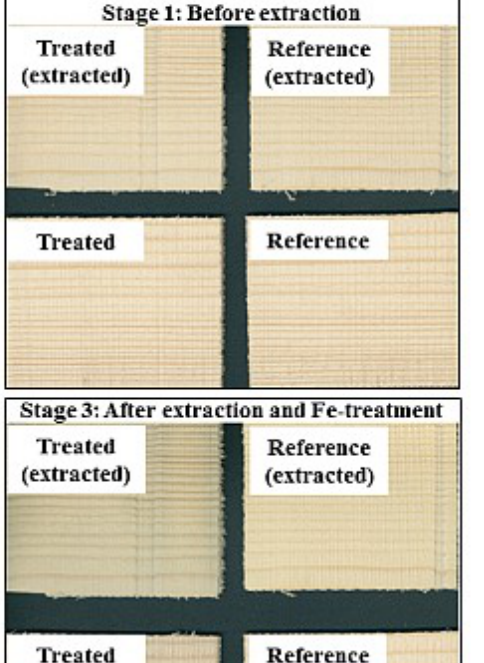
Figure 3. Scans of the extracted and non‐extracted spruce specimens of sample set 1 at four experimental stages. Treated = sulfate‐treated iron (II), R = untreated reference. Next to the specimens that were exposed to sunlight, specimens treated with iron (II) sulfate were kept in a ventilated box protected from sunlight (sample set 2); these specimens showed only minor color differences as compared to the exposed specimens (Figure 4 and Figure 5, Table 3).